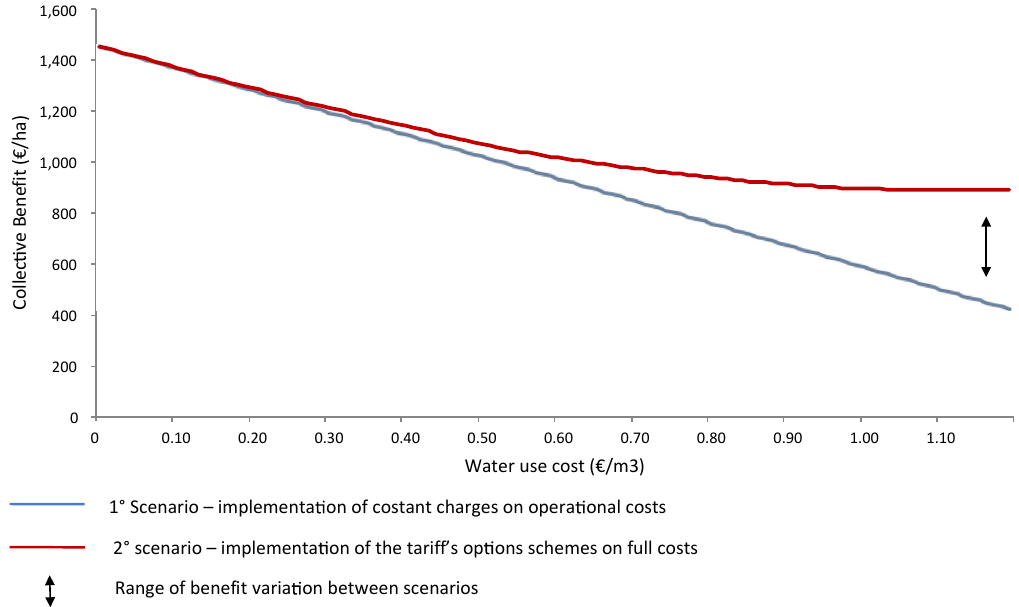
Figure 3. Benefit trends with increasing irrigation costs for the two